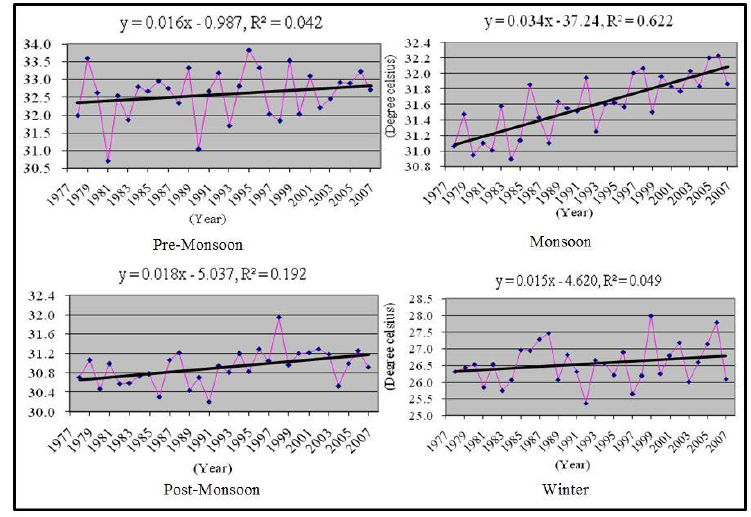
Figure 3. Annual mean maximum temperature for period 1978–2007.